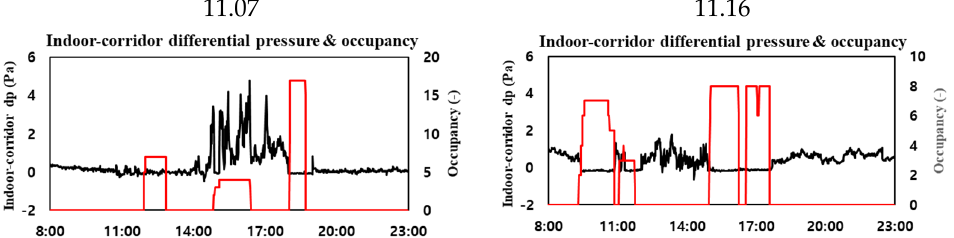
Figure 5. Checking the room–corridor differential pressure and occupancy data on 11/7 and 11/16. First, the data between 7 November and 14 November, when the ventilation system was not used, were compared with the actual value and the estimated occupant value output using the RF and ANN. The accuracy and RMSE of the RF are shown in Table 5. Both the Random Forest and ANN models, where the CO 2 concentration, mean value of the CO 2 concentration within 15 min, amount of change in the mean value of the CO 2 concentration within 15 min, and the ventilator operation mode were input, yielded the highest accuracy in Case 2. In the RF, the RMSE error yielded the lowest value at 1.462 in Case 2. In the ANN model, the lowest RMSE value was 1.544 in Case 4, where the CO 2 concentration, mean value of CO 2 concentration within 15 min, and amount of change in the mean value of the CO 2 concentration within 15 min were entered. In the model that learned the ventilation operation mode as an input value in a space where the mechanical ventilation was applied, both the RF and ANN models yielded the highest accuracy in Case 2, where the ventilation system operation mode was added as an input value even on days when the ventilation system was not operated (Figure 6). This is because in the remaining cases, except for Case 2 of the RF model and Cases 2 and 4 of the ANN model, when the CO 2 concentration decreased after the occupant had left the room, the learning model determined the presence of an occupant (Figure 6). In Case 2, where the ventilator operation mode was used as an input value, such a problem did not occur and the accuracy was inferred to be relatively high. In Case 2 of the RF model and Cases 2 and 4 of the ANN model, a situation occurred when numerous occupants left simultaneously, but it was determined that some occupants remained. However, this situation did not occur when